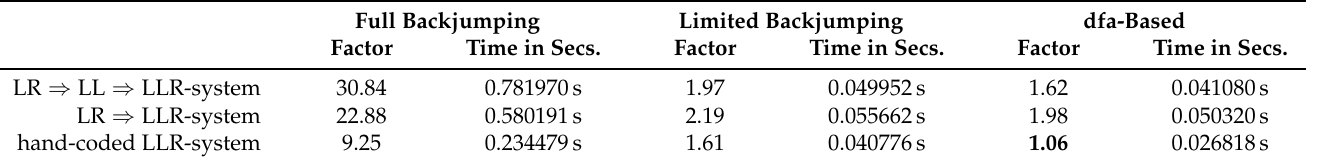
Table 3. The running times of scanning and parsing an arithmetic expression consisting of a million symbols using the full backjumping, limited backjumping, and DFA-based algorithm for the different LLR-systems derived from the context-free grammar in Example 6. Full Backjumping Limited Backjumping dfa-Based Factor Time in Secs. Factor Time in Secs. Factor Time in Secs.